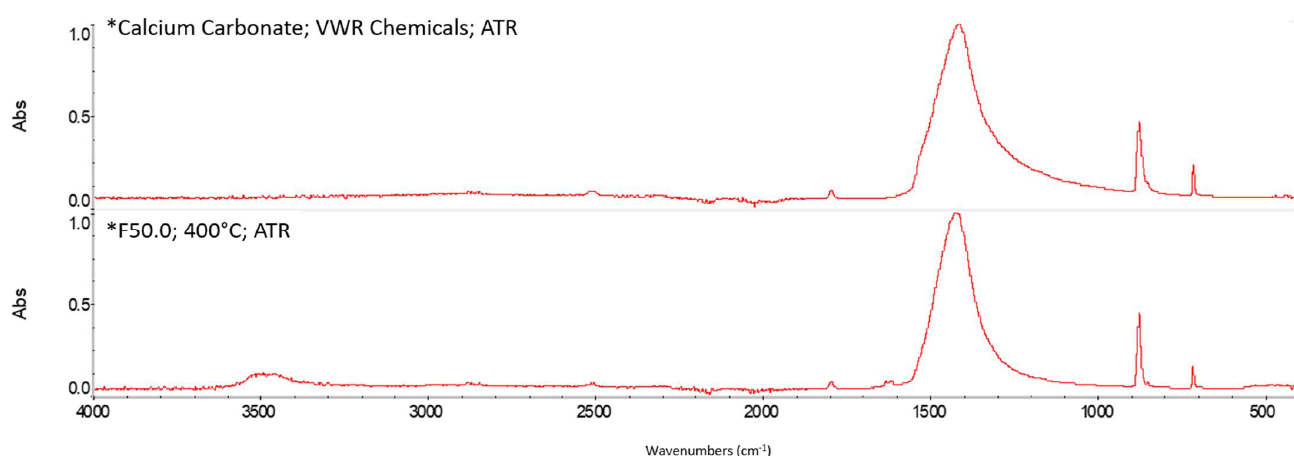
Figure A10. FTIR spectra: CaCO 3 versus ashes of F50.0 at 400 °C. F50.0 shows all the main CaCO 3 bands: 2509.64 cm −1 , 1794.92 cm −1 , 1417.26 cm −1 , 873.10 cm −1 , 846.70 cm −1 and 710.66 cm −1 .